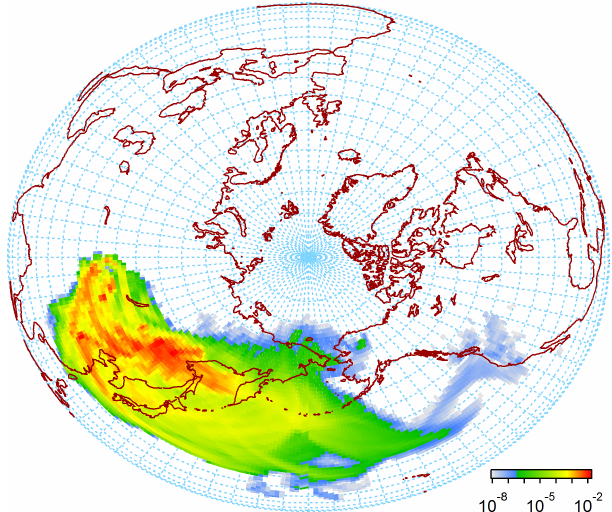
Figure 8. Forward trajectory analysis of dust transport (units: µgm − 3 ) in the free atmosphere using the FLEXPART model in 216h from 2 to 10 May 2017.